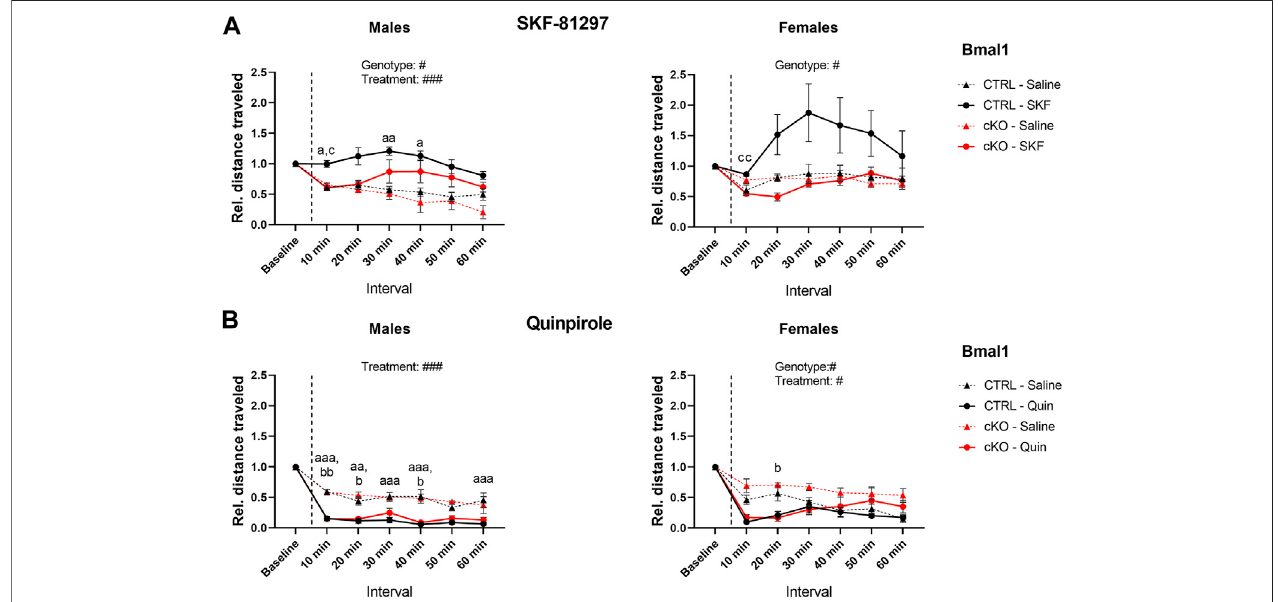
FIGURE 4 | Locomotor response to DRD1 and DRD2 agonist administration in mice with a conditional Bmal1 knockout. Changes in activity relative to baseline levels are depicted in 10-min intervals. Males and females with a conditional knockout of Bmal1 (n = t3 – 5 per sex and treatment) displayed an attenuated response to SKF-81297 compared to controls (n = 4 – 7 per sexand treatment) (A) . Activity was inhibited in males and females with a conditional knockout of Bmal1 (n = 3 – 4per sex and treatment) and controls (n = 4 – 8 per sex and treatment) following Quinpirole administration compared to saline injections (B) . Results are depicted as mean ± standard errorof themean (S.E.M.).Only genotype and treatment maineffectsare displayed inthe graph. # ... p ≤ 0.05, ### ... p ≤ 0.0005, three-way ANOVA. Letters indicatelevelsofstatisticaldifference betweengenotypeand treatment post-hoc comparison:a ... treatmenteffect CTRLgroup, b ... treatment effectcKO group,c ... genotypeeffectforSKForQuinpiroletreatment;oneletter ... p ≤ 0.05,twoletters ... p ≤ 0.005,threeletters ... p ≤ 0.0005,Tukey ’ smultiplecomparisonstest.Detailsof the statistical analysis are displayed in Table 3 .